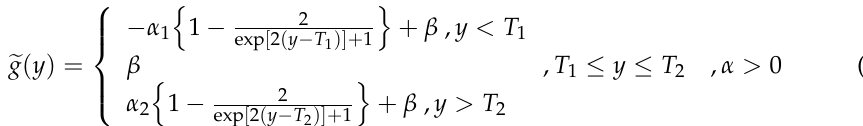
Figure 1. Curve of (cid:101) L ( y ) with constant compensation. Figure 1. Curve of   L y  with constant compensation. In the case of asymmetric quality compensation, the asymmetric-hyperbolic tangent grey quality compensation function can be expressed as: